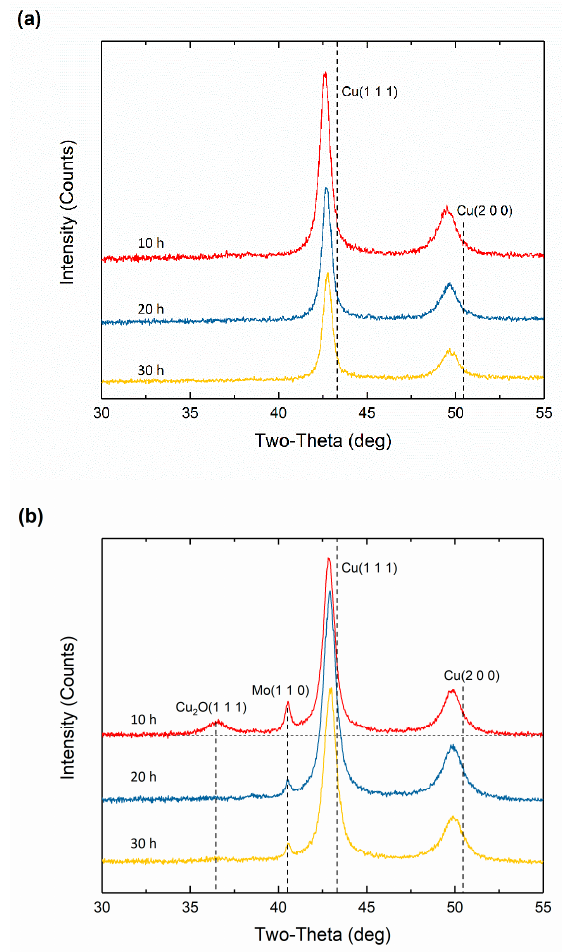
Figure 1. X-ray diffraction patterns of ( a ) Cu 65 Nb 5 Ag 10 (CuO) 10 and ( b ) Cu 65 Mo 5 Ag 10 (CuO) 10 alloys after 10, 20, and 30 h of milling.